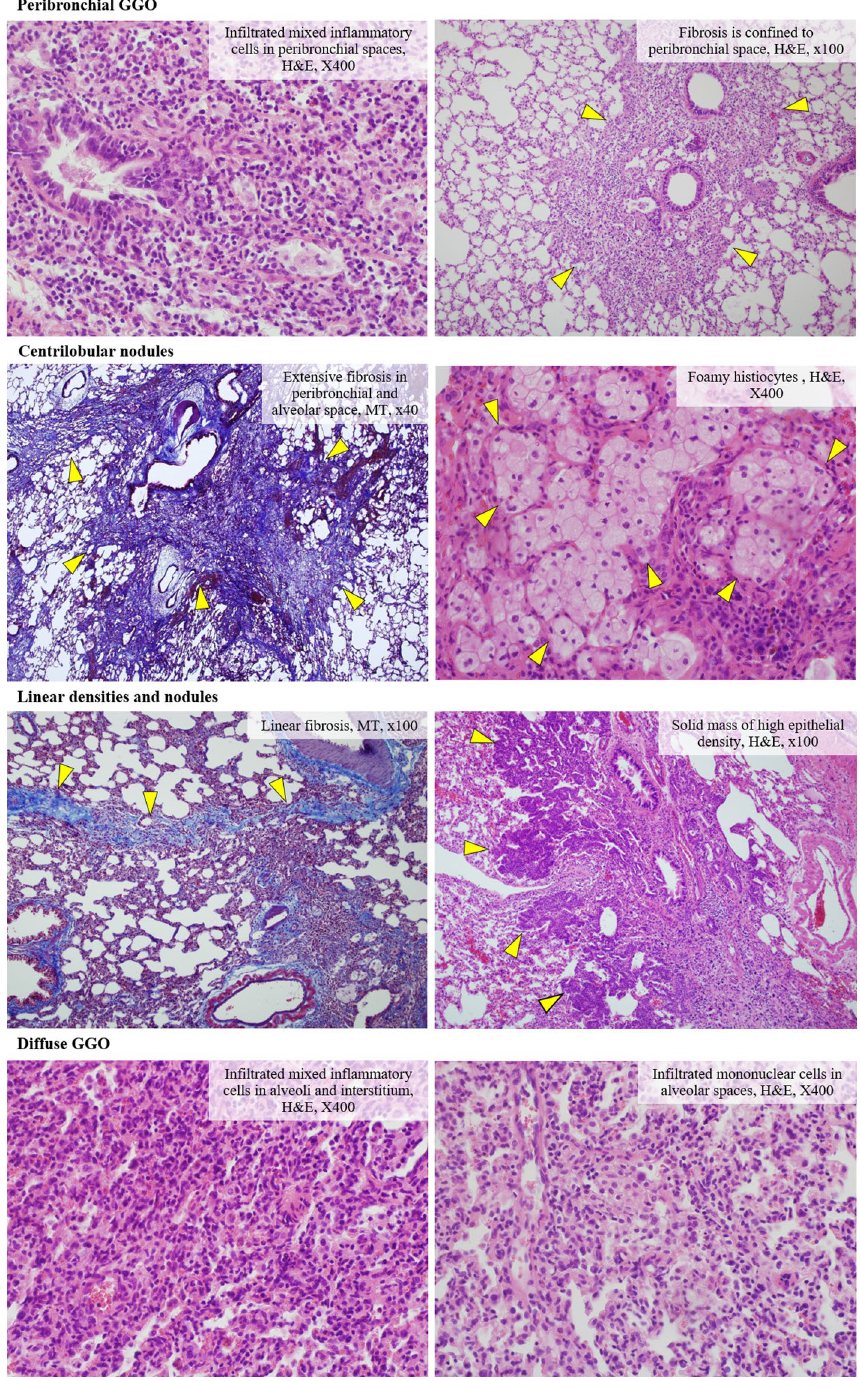
Figure 3. Four major CT findings and matched major histologic findings. Through radiologic-histologic correlation, 84.6% of peribronchial GGOs were inflammation and the rest were fibrosis. Centrilobular nodules were 60% fibrosis and the rest were inflammation. Linear densities and nodules were 62.5% inflammation, 25% fibrosis, and 12.5% tumors, and diffuse GGO was inflammation